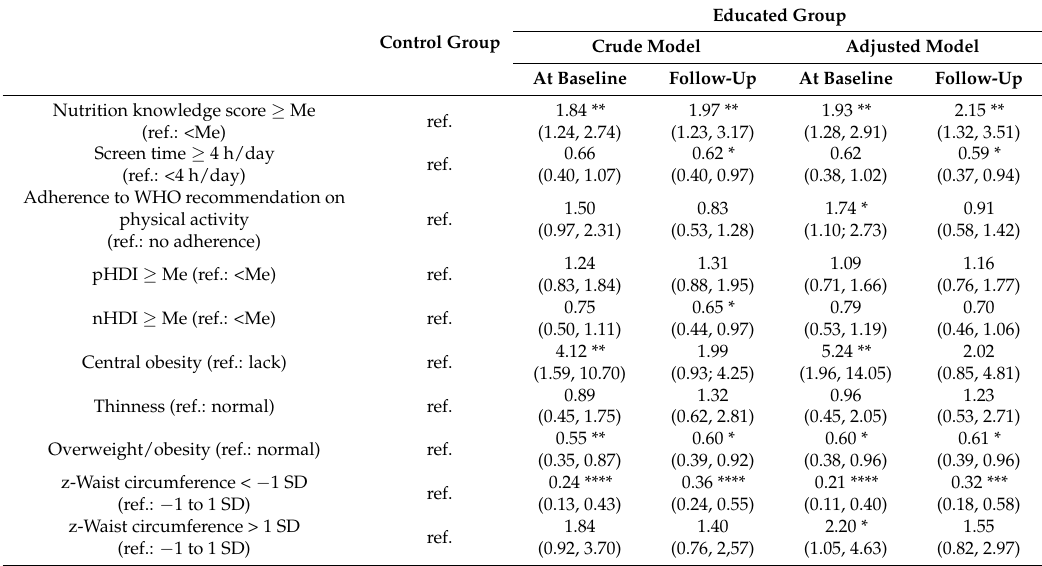
Table 5. Odds ratios (95% CIs) for nutrition knowledge, sedentary and active lifestyle, diet quality and body composition in the educated group at baseline and at a nine-month follow-up. Educated Group Control Group Crude Model Adjusted Model At Baseline Follow-Up At Baseline